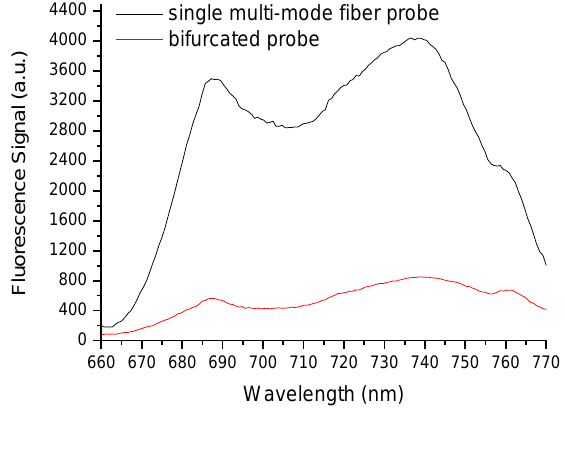
Figure 5. Fluorescence spectra of the Tall Fescue leaf. The fluorescence spectra were measured at 200 µW and at acquisition times of 200 ms for both the multi-mode fiber probe and bifurcated